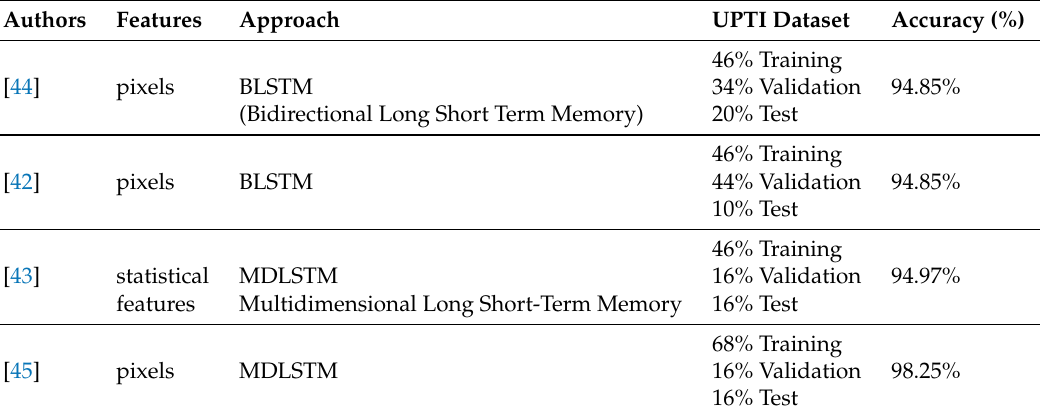
Figure 6. Classification of the initial half forms on the basis of the number of strokes [23]. MDLSTM, multidimensional long short-term memory. Table 1. Comparison of the proposed approach on the Urdu Printed Text Image (UPTI) dataset with other techniques